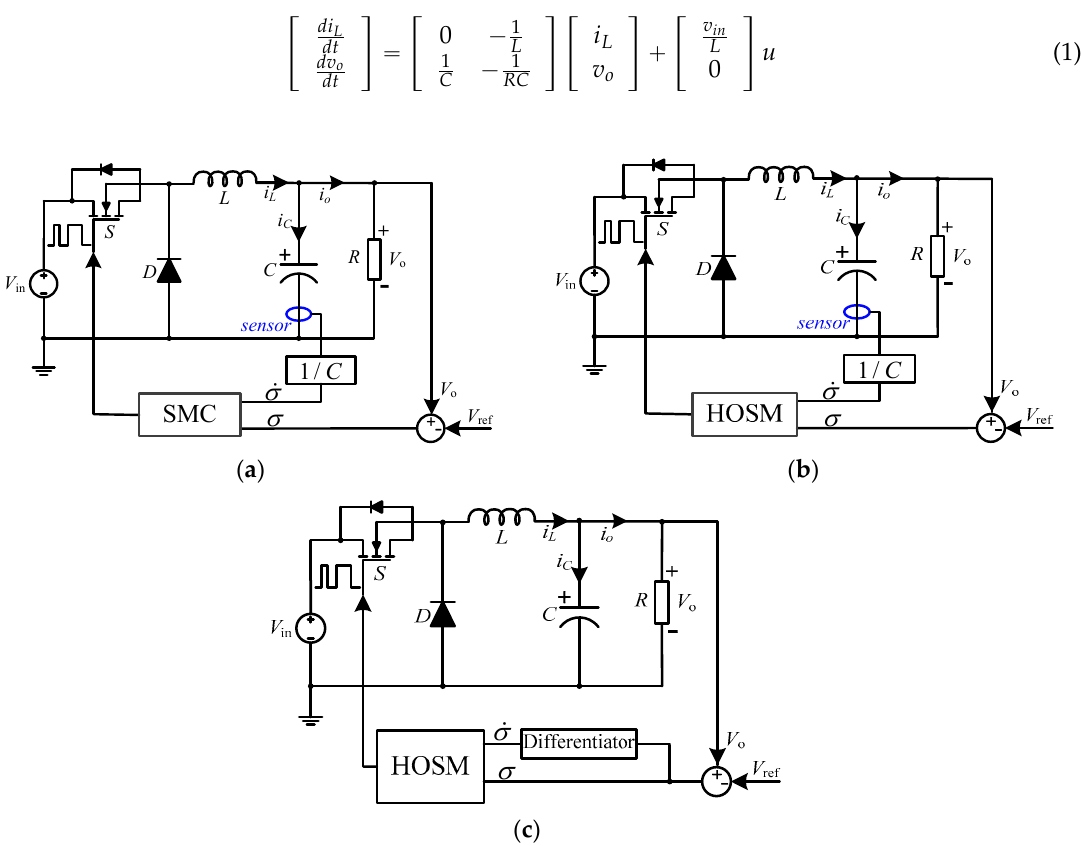
Figure 1. Basic structure of a buck converter: ( a ) SMC with measurements of both capacitor current and output voltage; ( b ) HOSM with measurements of both capacitor current and output voltage; ( c ) HOSM + STD (differentiator) with the only measurement of output voltage.